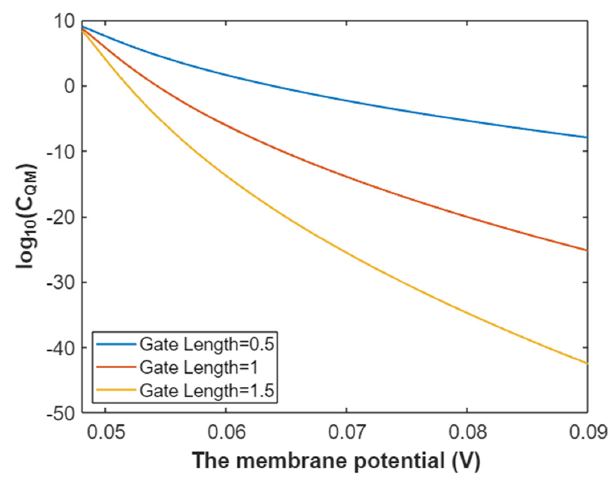
According to Equation (37), the relationship between membrane potential and the common logarithm of quantum membrane conductance of intracellular sodium ions can be plotted as in Figure 14. be plotted as in Figure 14.